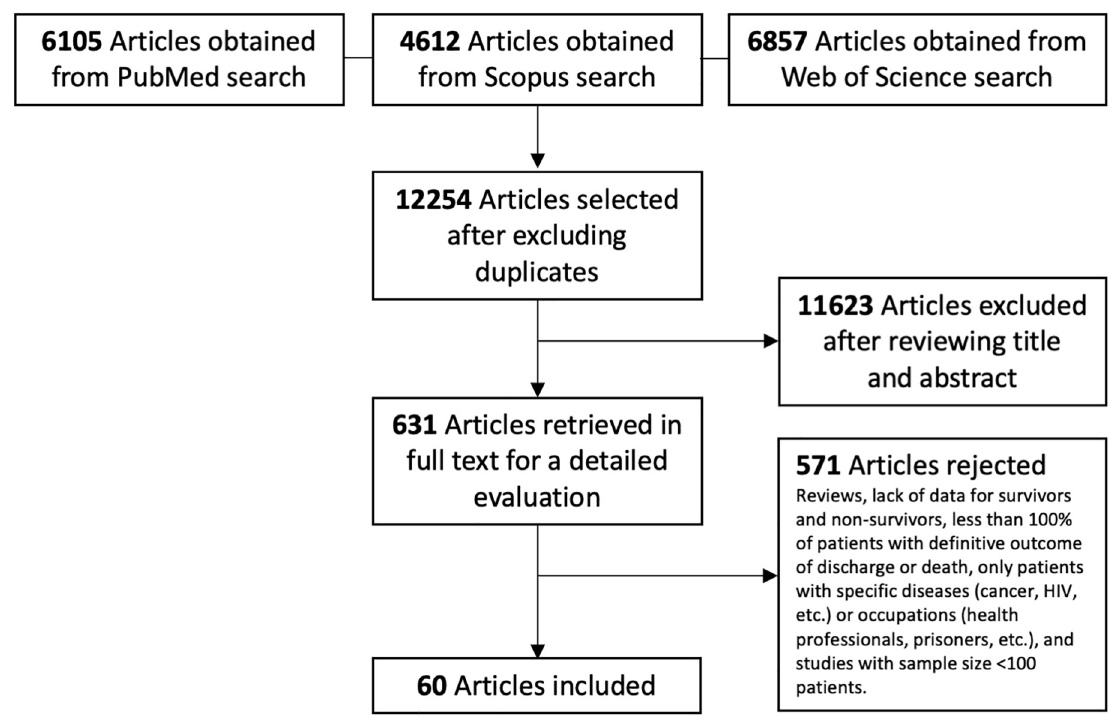
Fig 1. Flow diagram of the literature search and studies